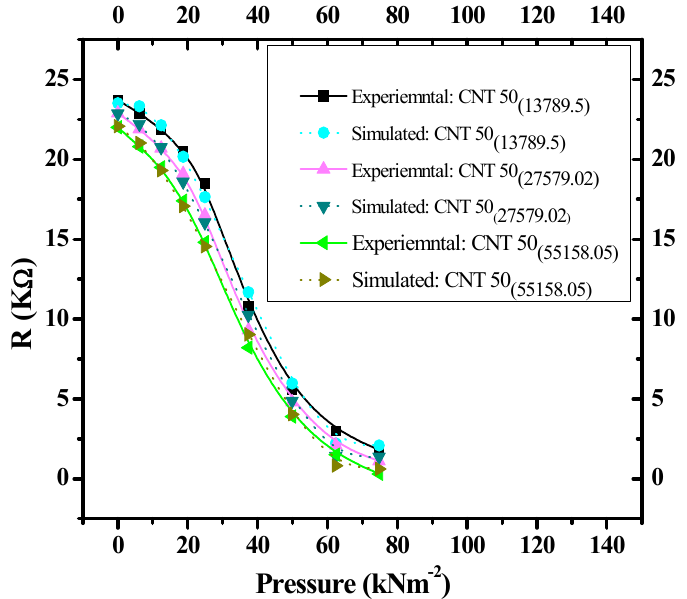
Figure 7. Resistance–pressure characteristics of experimental data (Figure 6) and simulated results (Equation (2)) for CNT–graphene composite-based piezoresistive pressure sensors with fabrication pressures of 13,789.5, 27,579.02, and 55,158.05 kNm − 2 .